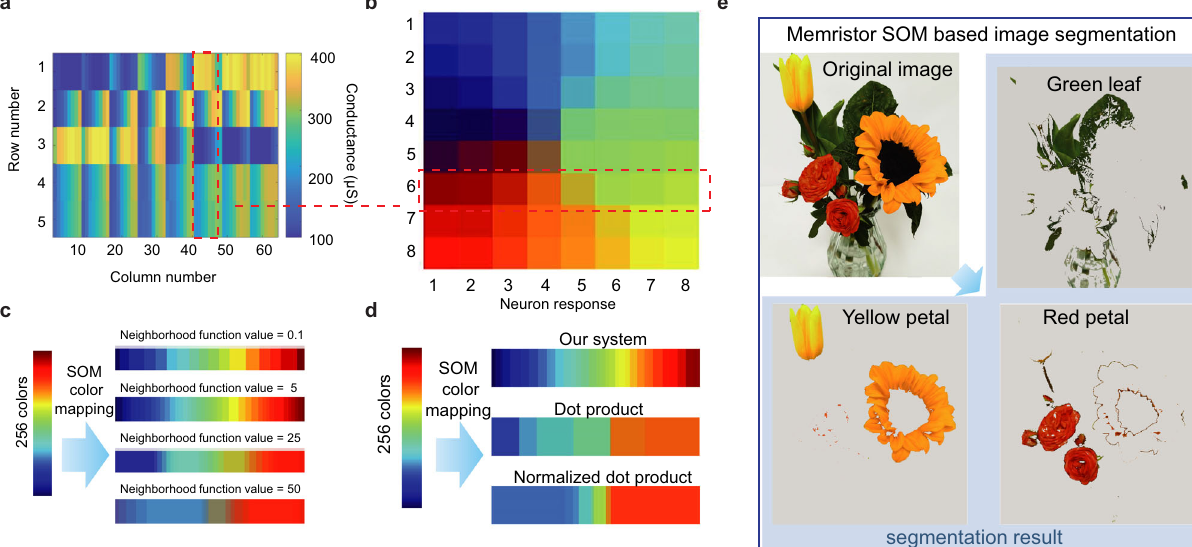
Fig. 2 Memristor-based SOMs for color mapping. a The conductance map of the 5 × 64 memristor array after the training process. The weights in the 1st to 3rd row are W data , representing the R, G, B components of the output nodes, while the weights in 4th to 5th are the W squared . b The self-organized topology pattern of the trained color mapping SOM. Each pattern is represented as the output neuron response. The chosen eight weight vectors in the memristor array (in the red box of a ) represents the weights of the nodes in the 6th row of 2D SOM. The color of the output nodes in the 6th row of 2D SOM (red box in b ) can be de fi ned by the R, G, B components in the of weight vectors in the memristor array (red box of a ). c Effect of the neighborhood function factor (from 0.1 to 50) on the mapping of 256 colors. The number of mapped colors is increased at fi rst and then decreased with the increasing of the neighborhood function factor. d Comparison of our SOM, dot product, and normalized dot product methods to calculate similarities for color mapping. The number of mapped colors based on our SOM is larger than the number of other methods, which means our SOM has a stronger color mapping ability. e SOM-based image segmentation. Three different clusters are de fi ned with the topology of output neurons. The original image has been segmented into three different sub-images, while the pixels in one sub-image are the nodes in the same cluster. The original image was segmented into three sub-images by different colors, while the fl owers can be segmented red petal, yellow petal, and green